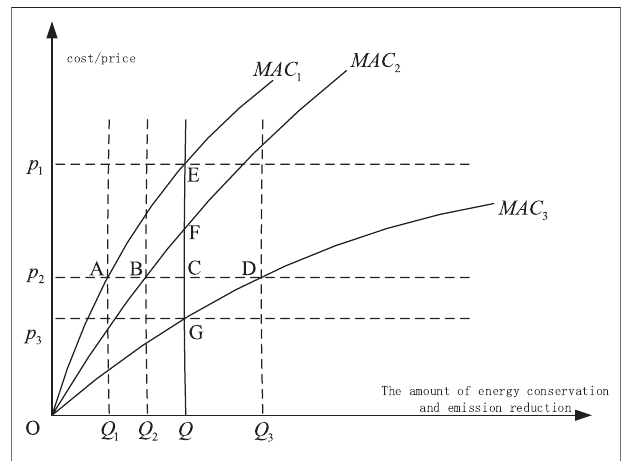
FIGURE 2 | Behavioral strategies of owner groups in carbon emissions permit trading in the public building